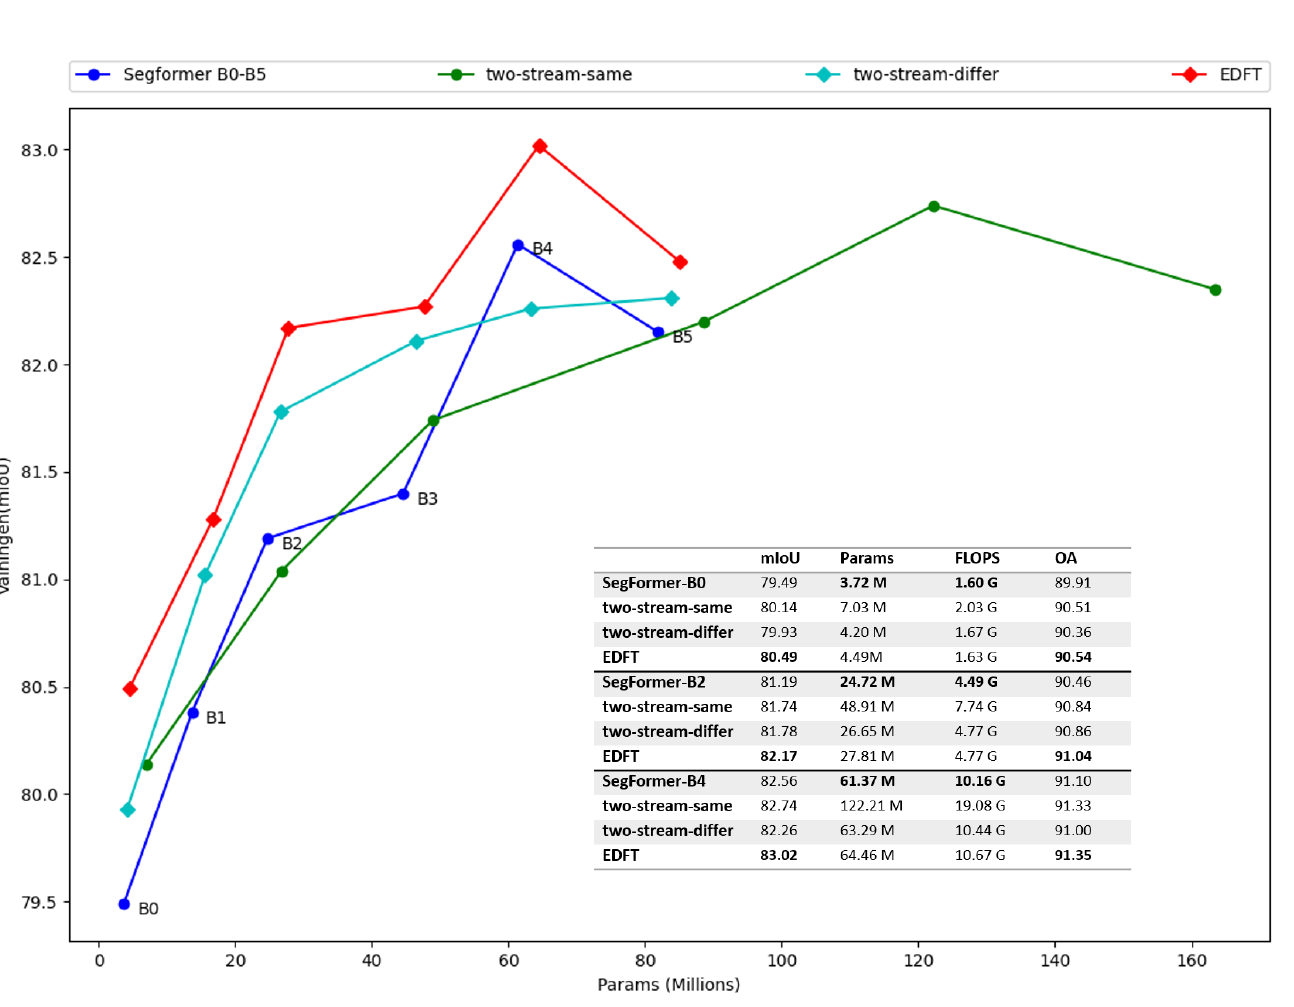
Figure 4. Performance and model efficiency on Vaihingen test set. For each best configuration, EDFT obtains 0.56% mIoU gains over the baseline method with additional 3.09 millions parameter, while traditional two-stream network (add-same) obtains 0.18% mIoU gains over the baseline method with additional 60.84 millions